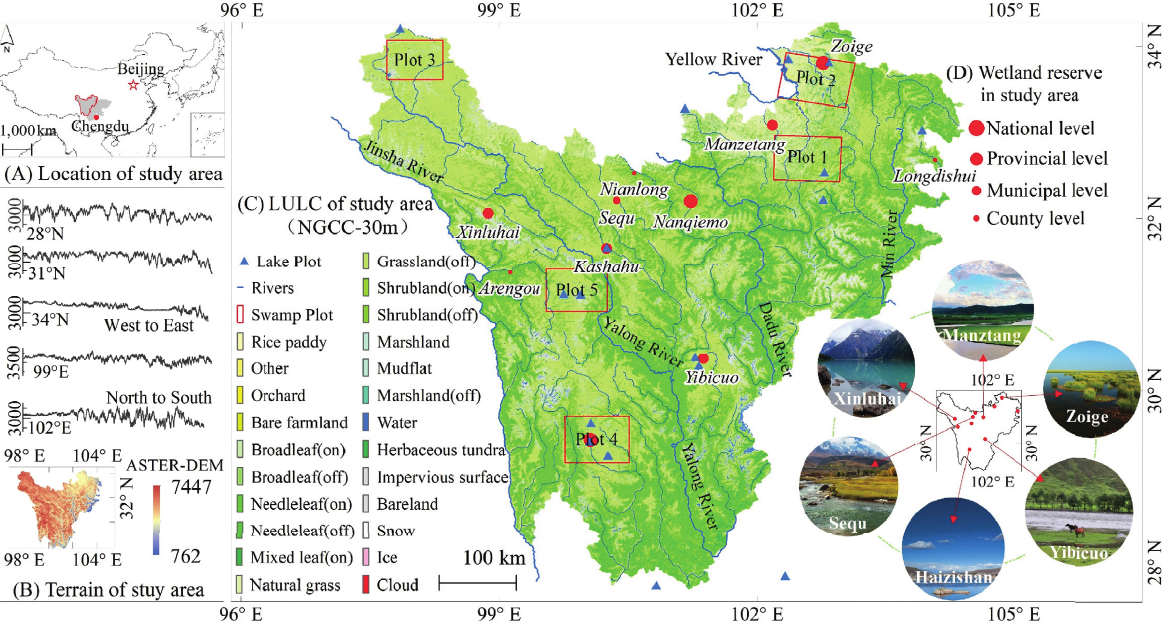
Figure 1: Geospatial feature of WSCP. (a) Location. (b) Terrain variation in latitudinal and meridional direction. (c) Land use and land cover. (d) Wetland nature reserve and its